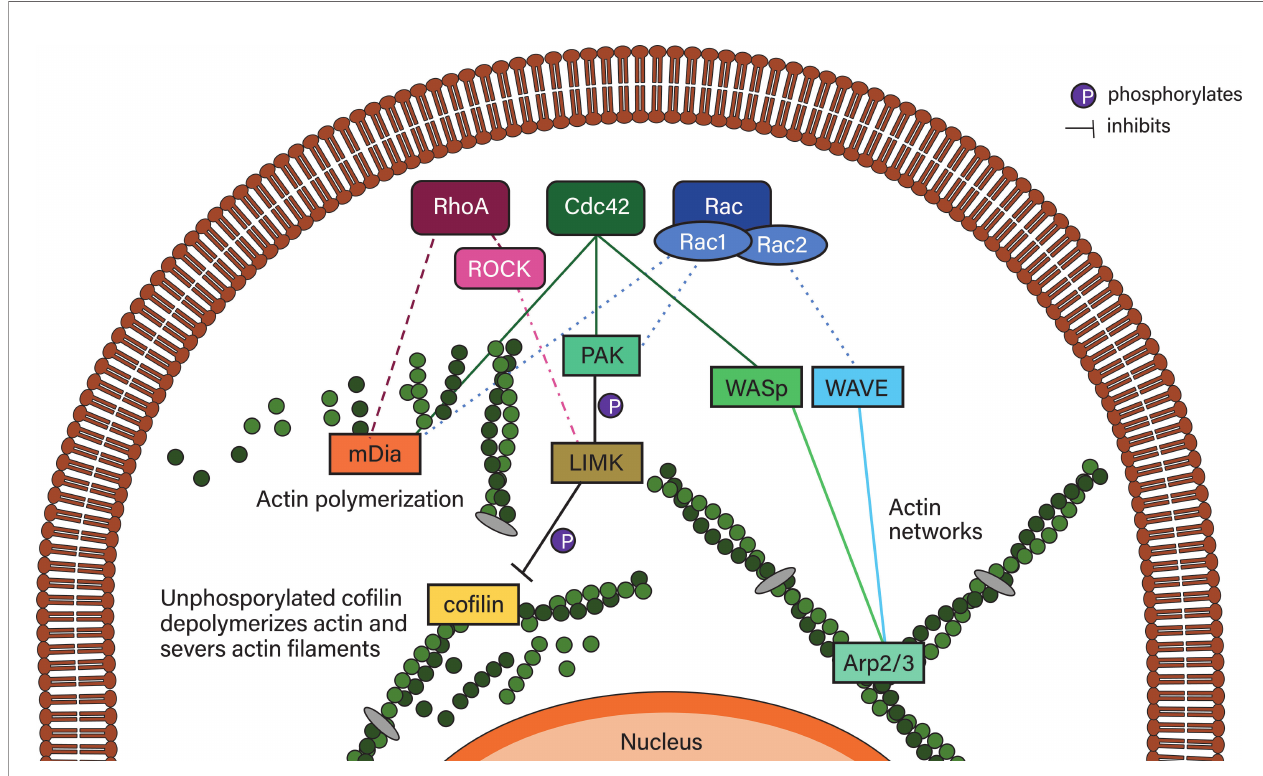
FIGURE 6 | Simpli fi ed RhoGTPase signaling to their downstream effectors. RhoA signals to mDia2 and, via ROCK, can inhibit actin depolymerization via LIMK/ co fi lin. Cdc42 can activate Rac proteins, which activates PAK proteins that phosphorylate LIMK family proteins, which phosphorylate and thereby deactivate co fi lin. Deactivated phosphorylated co fi lin is reactivated by dephosphorylation mediated by slingshot proteins such as SSHL1 (not shown). Cdc42 also initiates actin polymerization via mDia2 and actin network formation (typically in lamellipodia/lamella) via WASp, which activates Arp2/3. Arp2/3 is also activated by the WAVE complex of which hem1 is an associated protein. WAVE is activated by Rac proteins such as Rac1 and Rac2. Rac proteins also activate mDia2 as well as the PAK/ LIMK/co fi lin